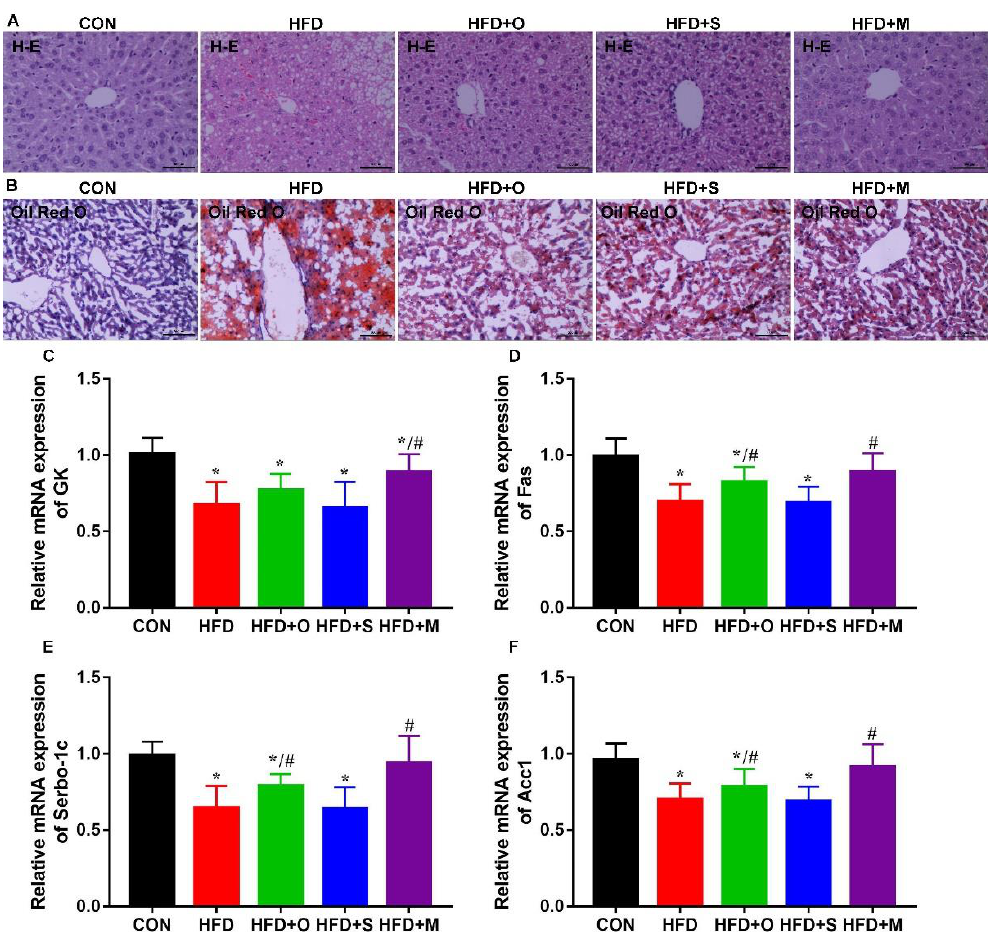
Figure 6. Effects of Octa monomer and microcapsule on hepatic lipid metabolism. ( A ) H − E staining (200 ×, scale bar = 100 μm). ( B ) Oil Red O staining (100 ×, scale bar = 200 μm). ( C − F ) The mRNA expression of lipid − metabolism − related genes in liver: ( C ) GK. ( D ) Fas. ( E ) Srebp1c. ( F ) Acc1. * p < 0.05, when compared with the CON group. # p < 0.05, when compared with the HFD group.